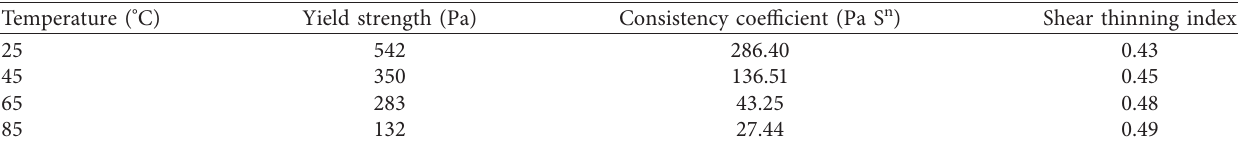
Figure 3: Curve of the apparent viscosity of NLGI 1 lithium-based lubricating grease as a function of the shear rate. Table 2: Rheological parameters of NLGI 1 lithium-based lubricating grease at various temperatures.